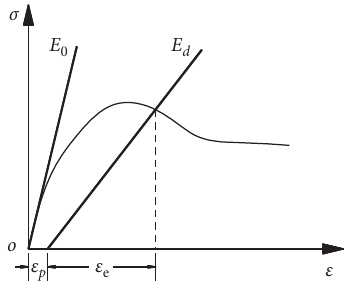
Figure 3: Stress and strain of damage soil.